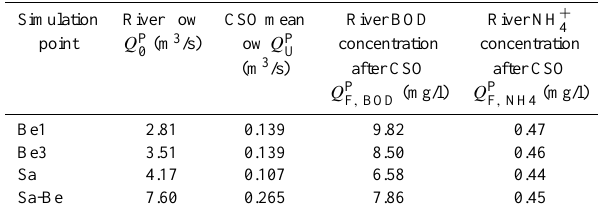
Table 5. Average flow volumes and starting time of the CSO for a non-exceedance probability P =0.75.